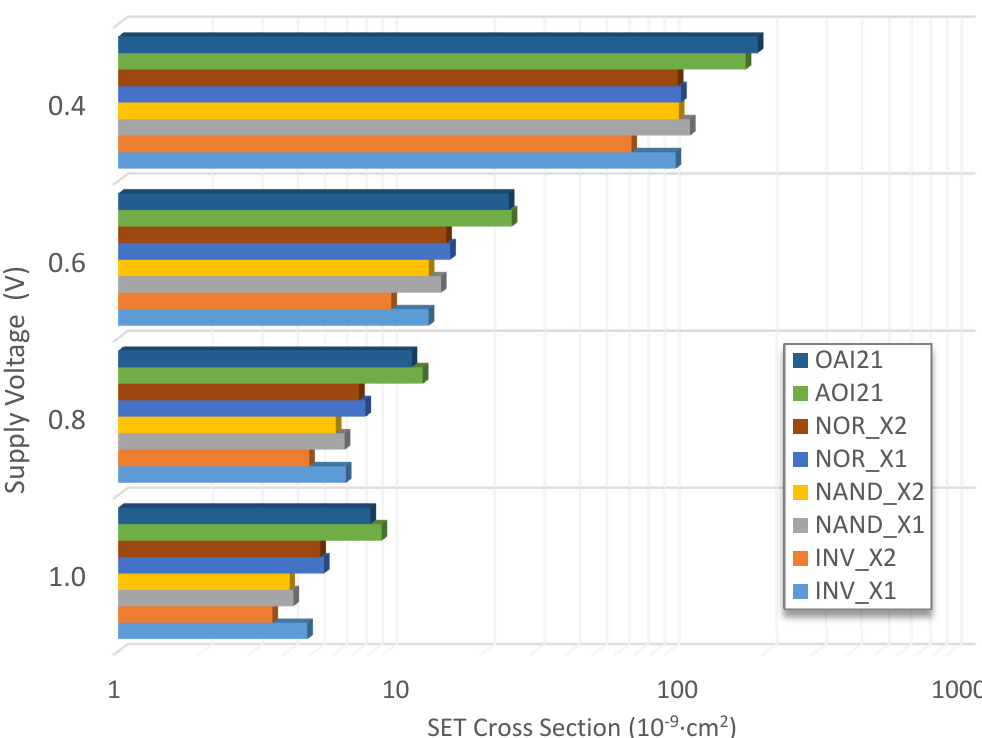
Figure 6. Estimation of the dynamic voltage scaling impact on the SET cross-section of the standard cells.